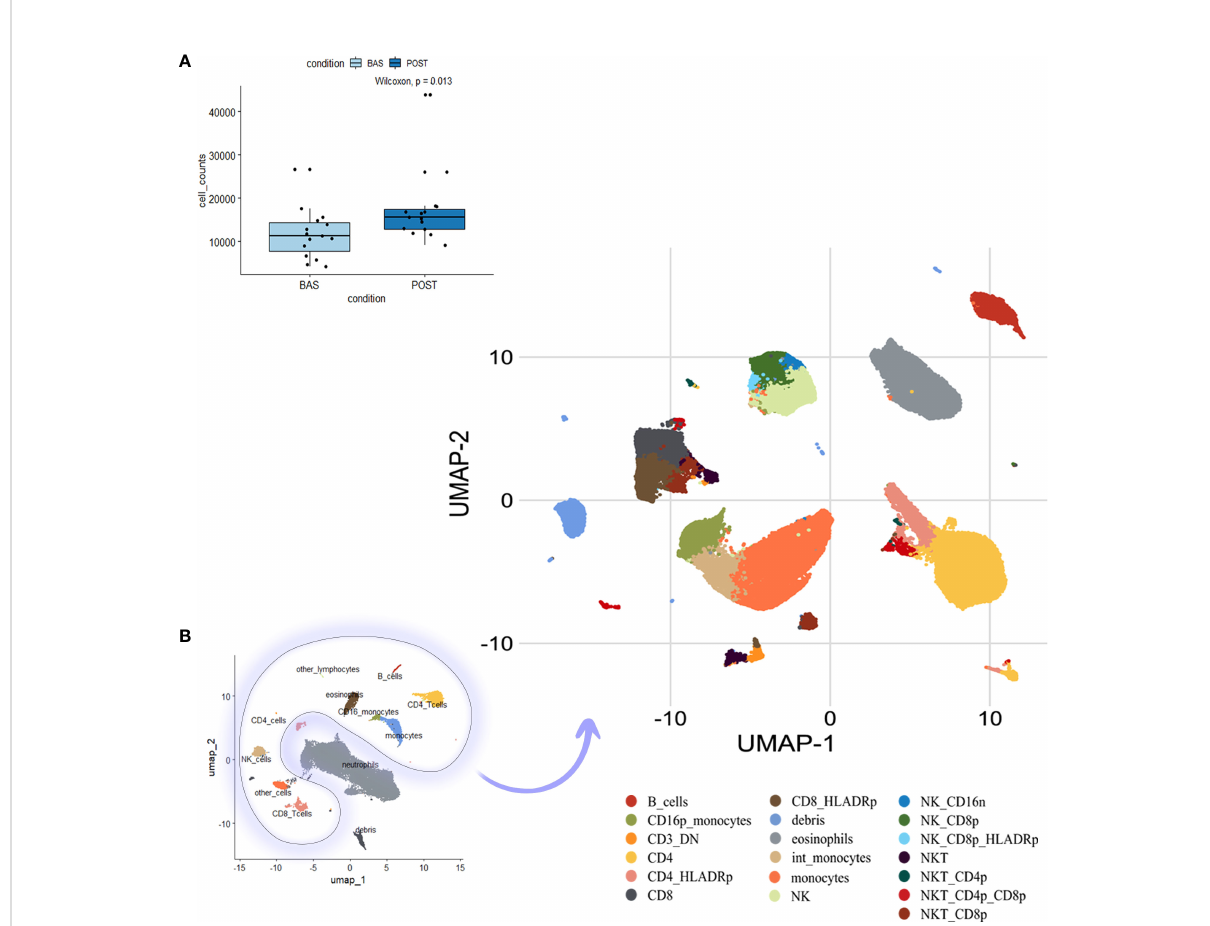
FIGURE 1 Cell clustering and phenotype identi fi cation of PBMCs of mNSCLC patients. Previously compensated fl ow cytometry standard (FCS) fi les have been used for large-scale immune monitoring using FlowCT. (A) Cell number per time point (basal (BAS) vs. post-treatment (POST) after pre-processing, quality control, and normalization. (B) Uniform manifold approximation and projection (UMAP) dimensionality reduction techniques for full visualization of 19 independent clusters. PBMC, Peripheral blood mononuclear cells; mNSCLC, metastatic non-small cell lung